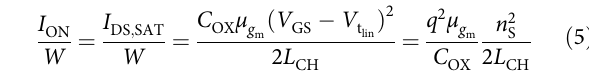
Fig. 7 Drive current and saturation velocity. Median of drive current ( I ON ) as a function of 1/ L CH for a MoS 2 and b WS 2 FETs at V DS of 1 V corresponding to the linear region of the FETs, and c MoS 2 and d WS 2 FETs at V DS of 5 V corresponding to the saturation region of the FETs. These are extracted at carrier concentrations ( n S ) of 1 × 10 13 cm − 2 and 4.4 × 10 12 cm − 2 for MoS 2 and WS 2 , respectively. The saturation current ( I DS,SAT ) for e MoS 2 and f WS 2 , extracted from their corresponding shorter-channel devices ( L CH < 1 μ m) as a function of n S . The slope indicates the saturation velocity ( v SAT ). The distribution of v SAT for g MoS 2 and h WS 2 shorter-channel V DS = 5 V for both MoS 2 and WS 2 FETs in Fig. 7c, d, respectively, following Eq. (5).